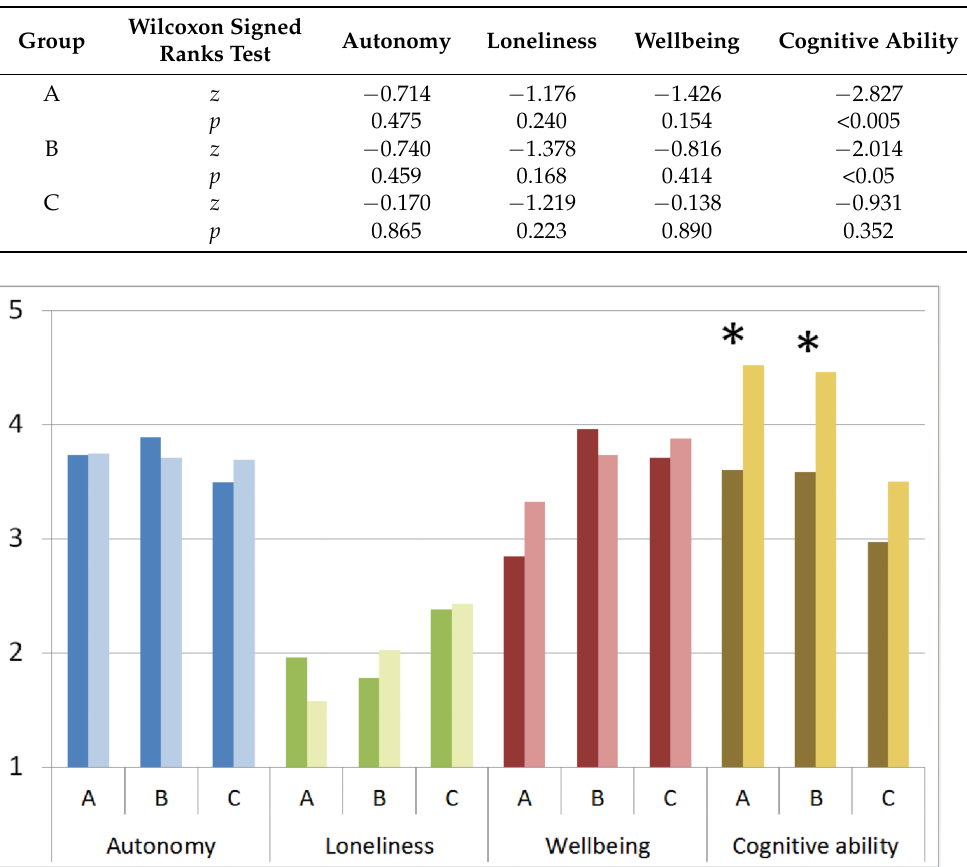
Table 4. Pre-post comparisons of cluster variables of perceived wellbeing, autonomy, loneliness, cognitive ability.